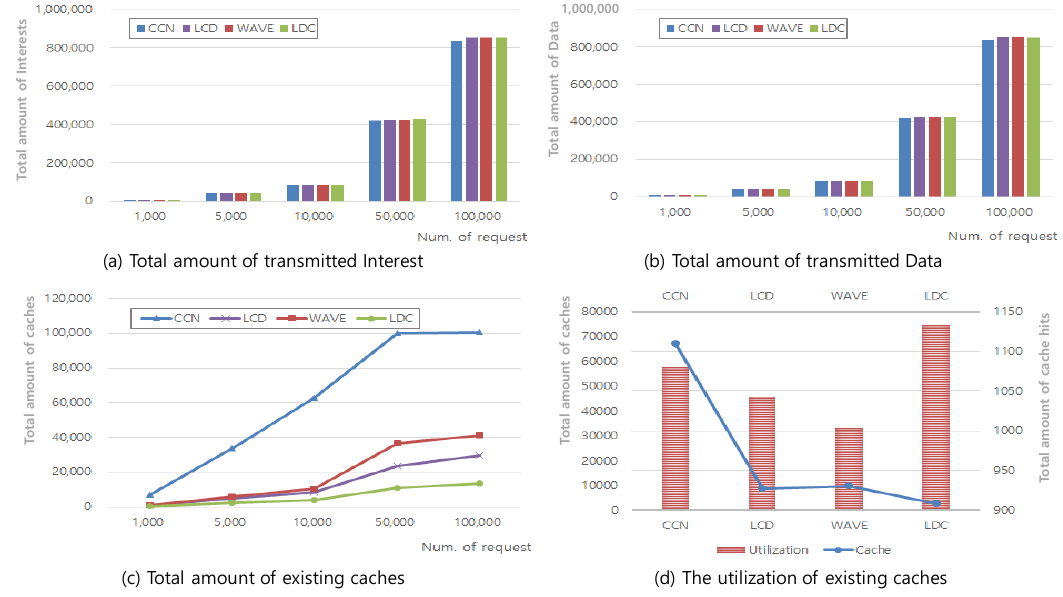
Figure 6. Performance simulation result.